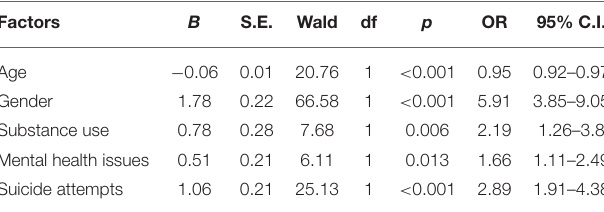
TABLE 3 | Factors associated with the removal of children*.